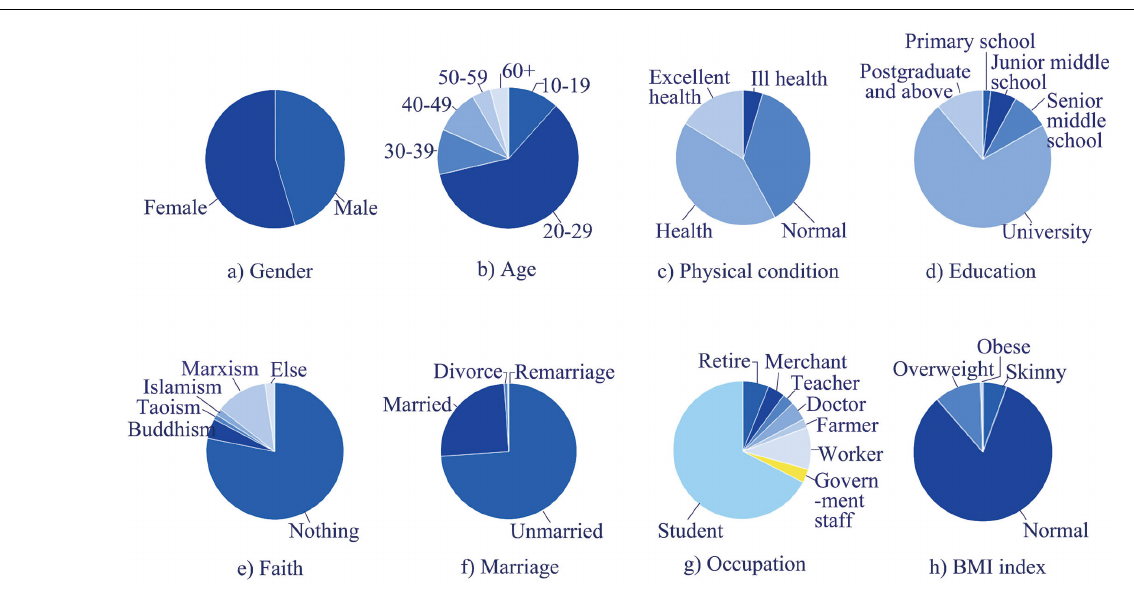
FIGURE 3 | Distribution of essential characteristics of respondents. BMI is a commonly used index to measure the degree of obesity and health in the world. The average value of BMI is between 20 and 25, more than 25 is overweight, and more than 30 is obesity. (a) Gender. (b) Age. (c) Physical condition. (d) Education. (e) Faith. (f) Marriage. (g) Occupation. (h) BMI